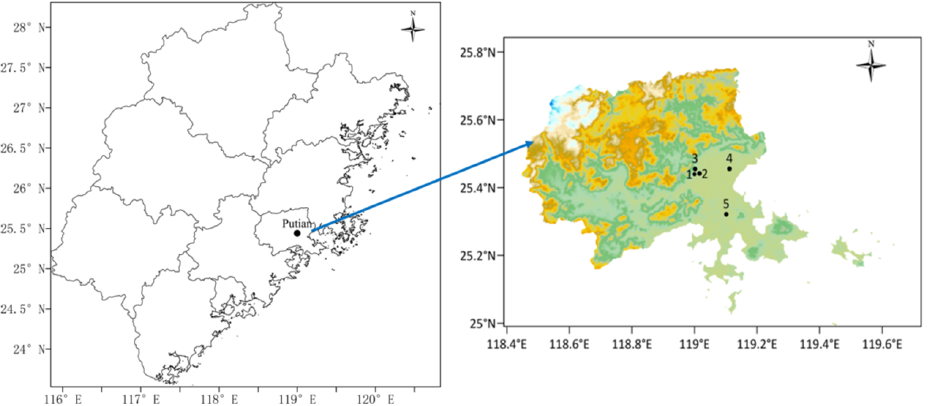
Figure 1. Distribution of meteorological station and environmental monitoring station in Putian (1. Meteorological Station; 2. Canghou Road; 3. Environmental monitoring station of Putian; 4. Hanjiang No. 6 middle school; 5. Xiuyu district